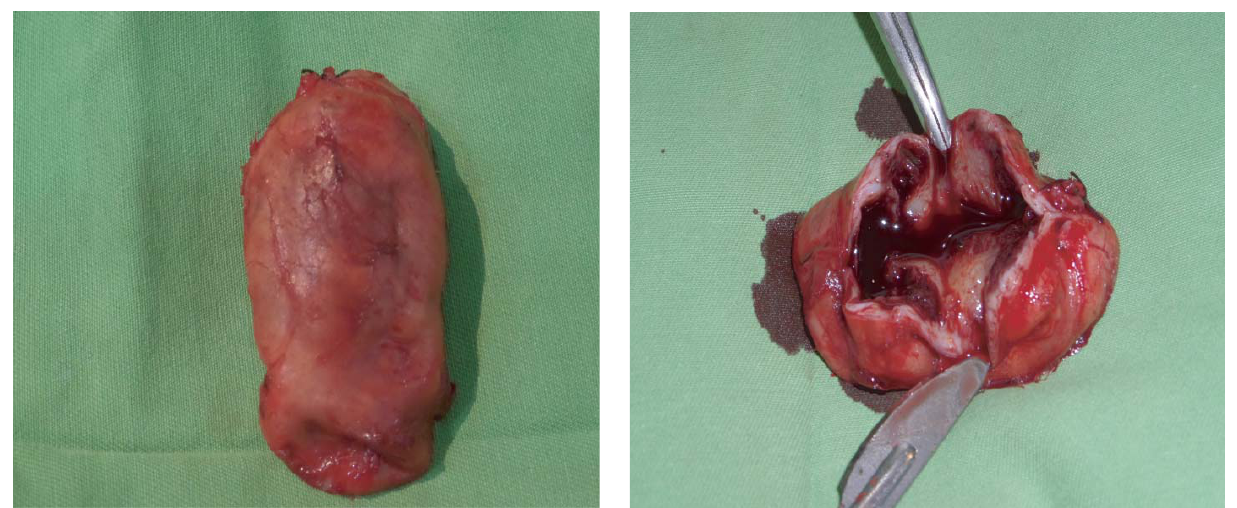
Fig 3. Exterior and interior features of the resected